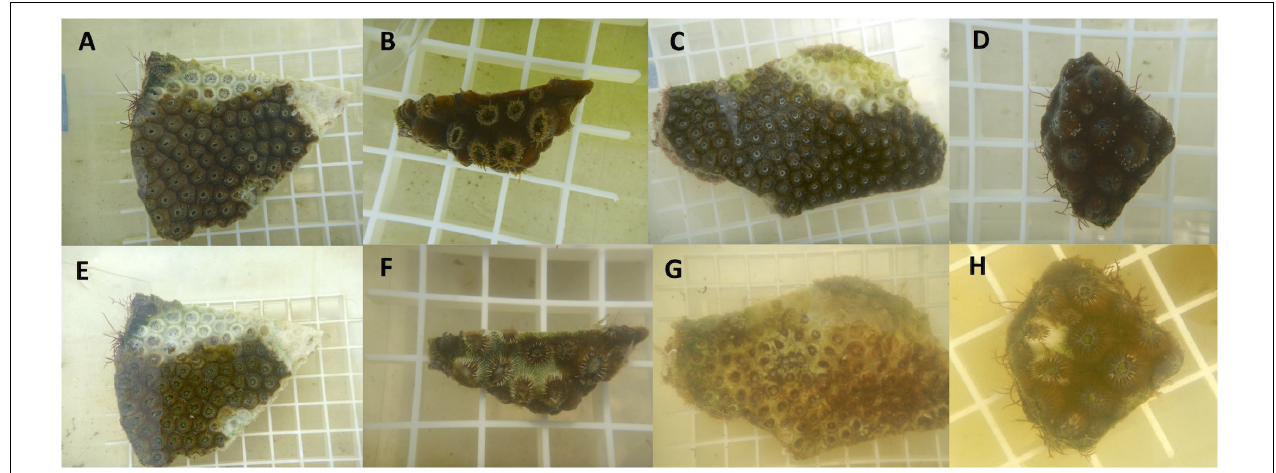
FIGURE 9 | Examples of disease transmission from aquaria studies. Top row are fragments on day 0 (A–D) and bottom row are following disease transmission after 2–3 days exposure (E–H) . Fragment (A) is the diseased fragment from Fort Lauderdale and fragment (B) was the healthy test piece touching the lesion. Fragment (C) is the diseased fragment from the Lower Keys and fragment (D) is the healthy test piece. Fragments (B) , (D) are